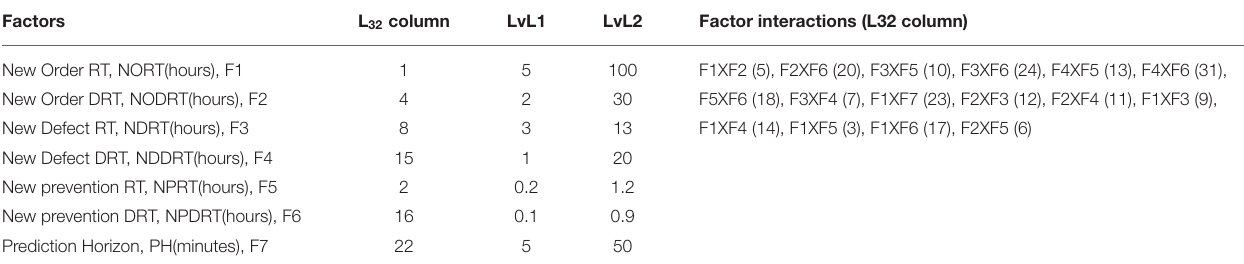
TABLE 1 | Factor levels and